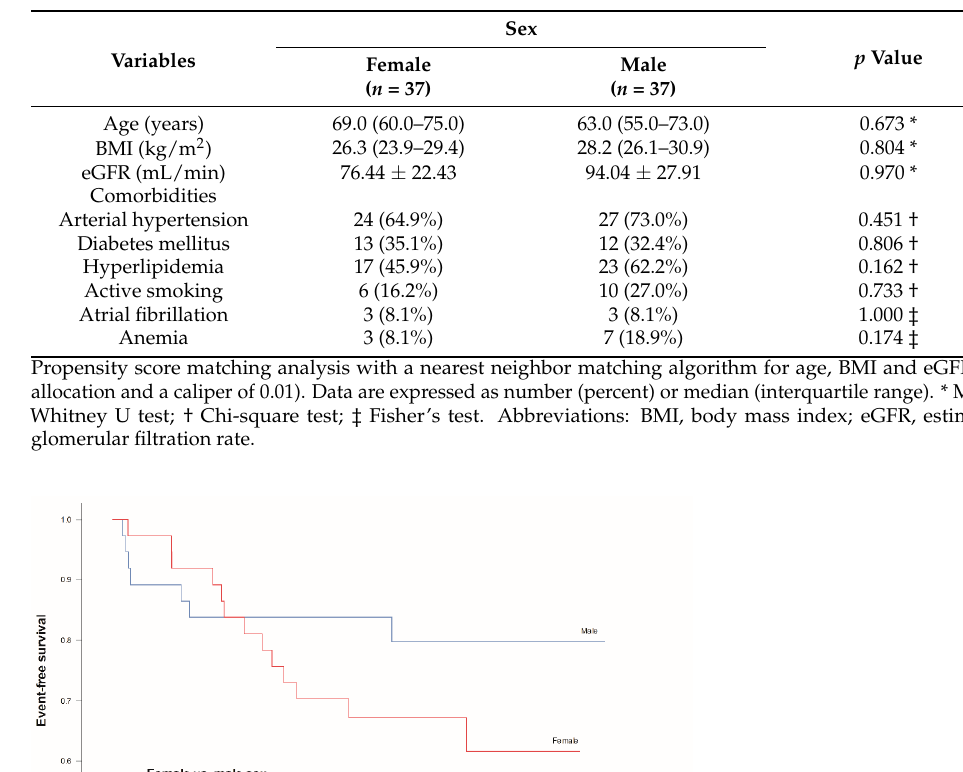
Figure 3. Event-free survival for MACCE according to sex. Legend: MACCE, major adverse cardiovascular and cerebrovascular events (composite of cardiac mortality, ischemic stroke, urgent coronary revascularization and nonfatal myocardial infarction). Table 3. Adverse events during the study period.